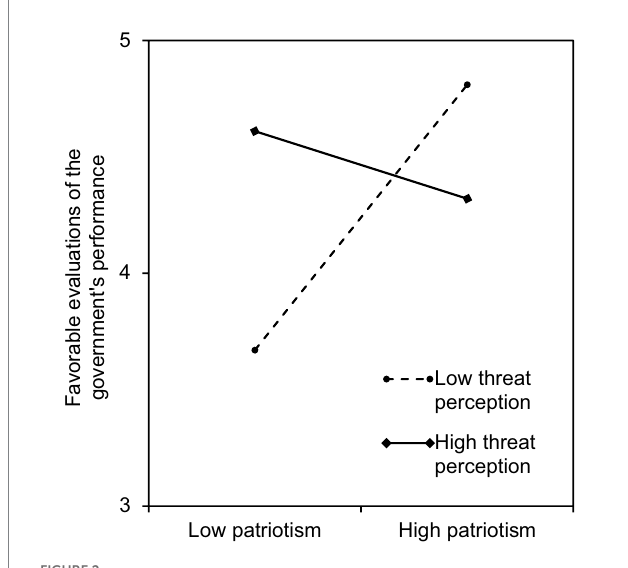
FIGURE 2 Interaction effects of patriotic feelings and treat perceptions on favorable evaluations of the governments performance, p <